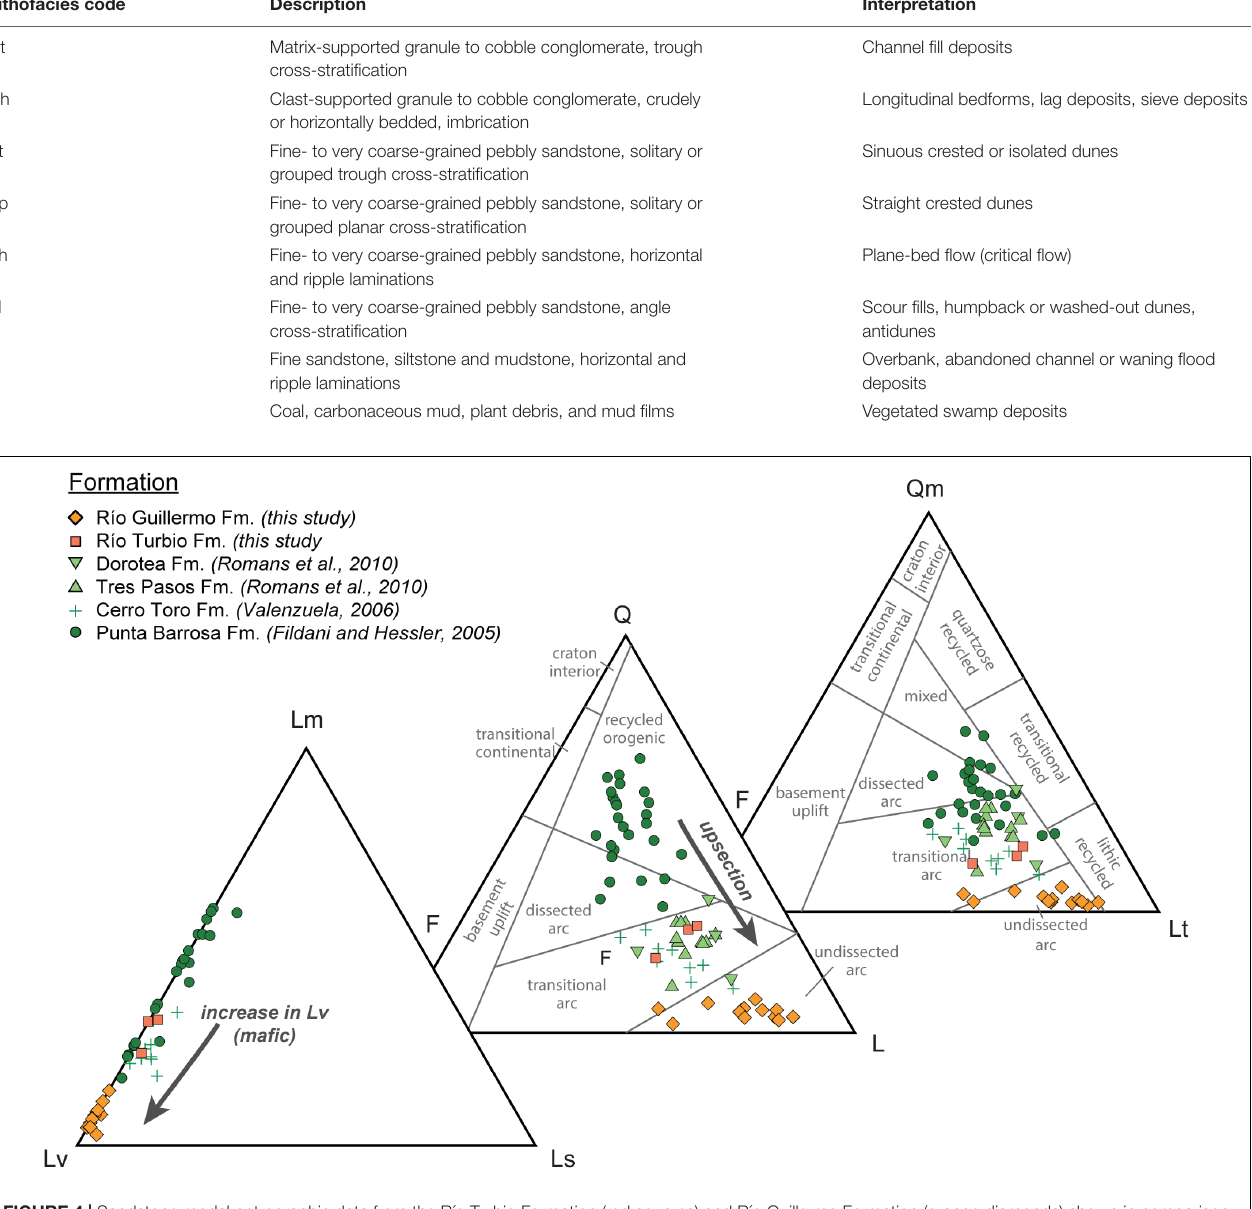
FIGURE 4 | Sandstone modal petrographic data from the Río Turbio Formation (red squares) and Río Guillermo Formation (orange diamonds) shown in comparison to published petrographic data from the Magallanes-Austral Basin. Refer to Table 3 for parameters. Tectonic provenance fields are from Dickinson (1985). QFL (Quartz-Feldspar-Lithics) and QmFLt (Monocrystalline quartz-Feldspar-Lithic total) data show an upsection trend of decreasing in compositional maturity toward undissected arc source areas. LmLvLs data show a shift from Lm toward Lv, suggesting that the influx of mafic volcanic arc sediment is swamping any other recycled orogenic sources. Published datasets from the Upper Cretaceous basin infill are compiled from Fildani and Hessler (2005), Valenzuela (2006), and Romans et al.